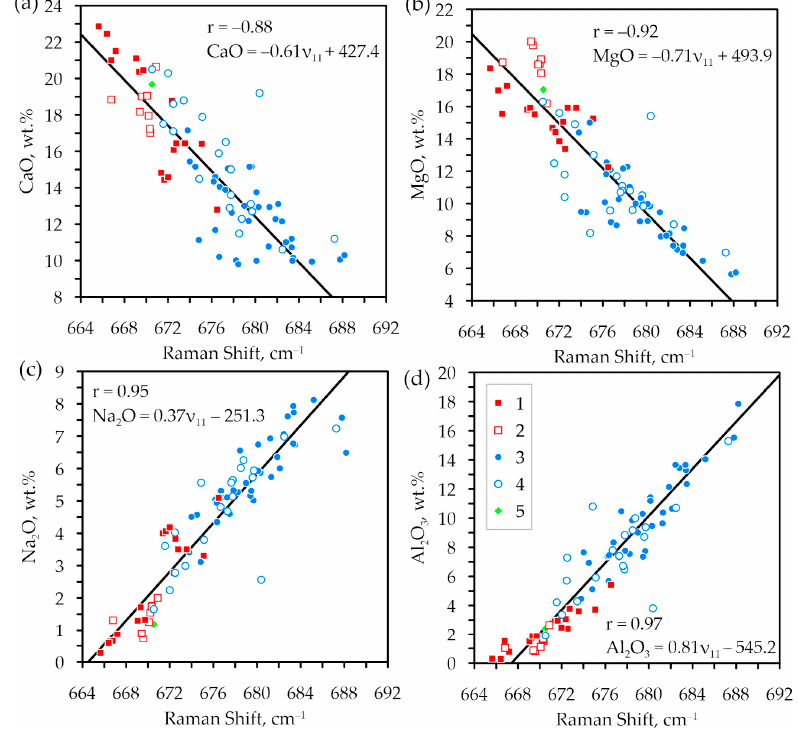
Figure 4. The correlation of the Raman shift of the frequency position of O-Si-O br mode ( ν 11 ) in clinopyroxenes with contents of CaO ( a ), MgO ( b ), Na 2 O ( c ), and Al 2 O 3 ( d ) determined from EPMA: 1—peridotite clinopyroxene inclusions in diamonds, 2—clinopyroxenes from peridotites, 3—eclogite clinopyroxene inclusions in diamonds, 4—clinopyroxenes from eclogites; 5—single clinopyroxene inclusion in diamond with transitional composition [2]. The equations of Deming regression lines (1–4) are